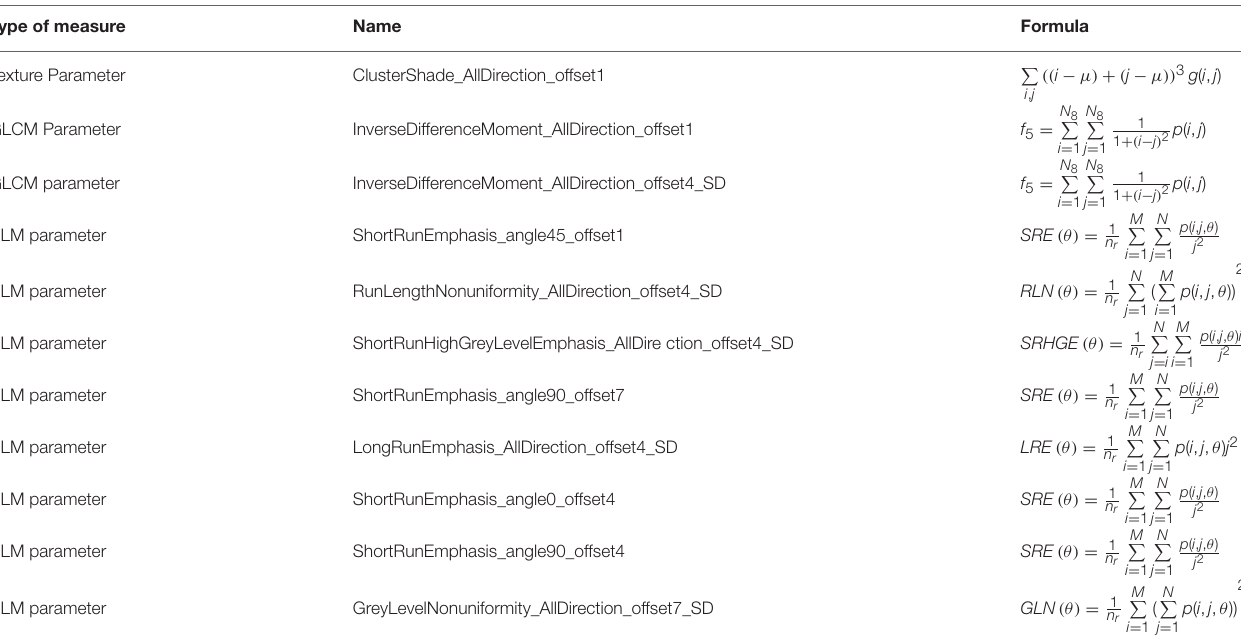
TABLE 1 | Definition of the features measures computed in this study after feature